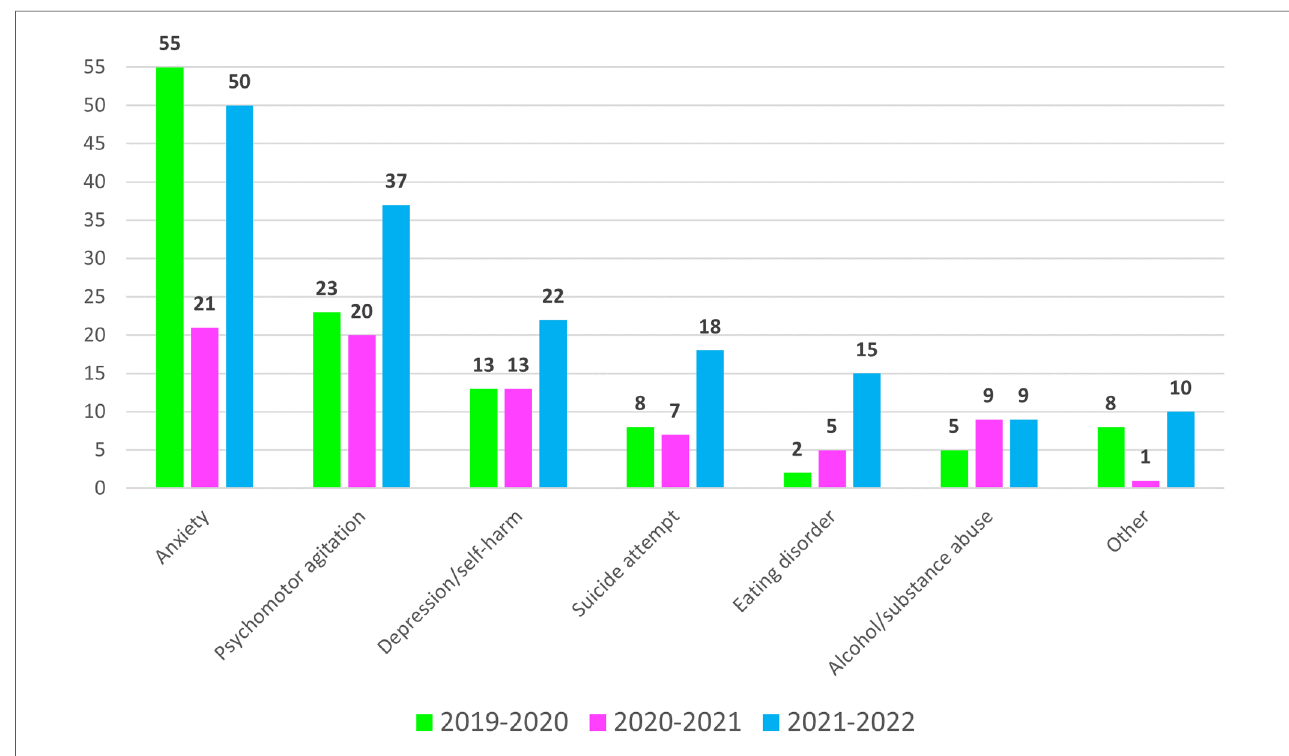
FIGURE 1 Number of urgent psychiatric consultations during the study period detailed for every mental health